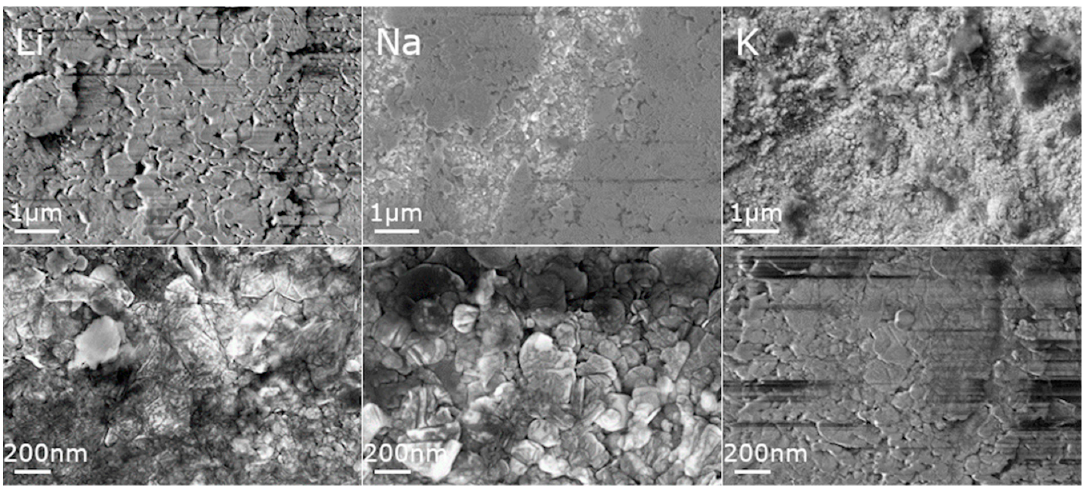
Figure 5. SEM micrographs of La 0.9 A 0.1 MnO 3 (A: Li— left , Na— center , K— right ) ceramics.